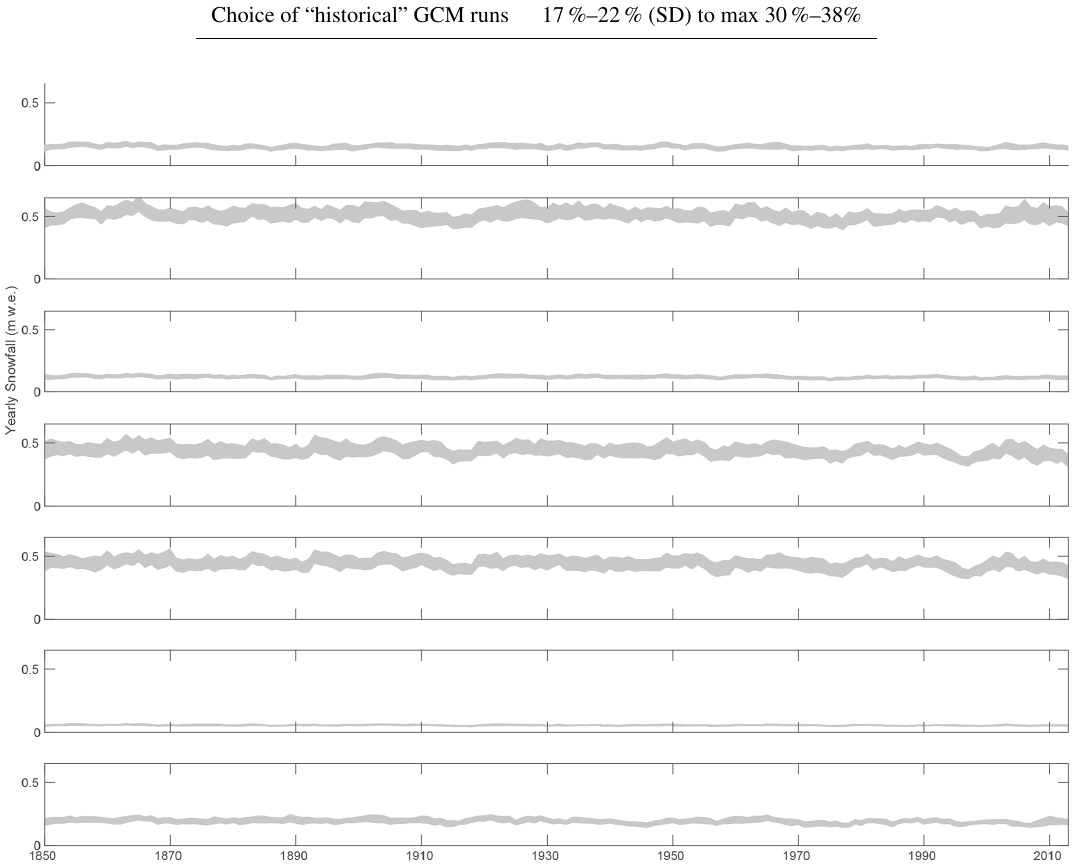
Figure 11. The downscaled CESM2 member 1 with 100 different analog draws is represented at the ice core sites. The uncertainty is between 5% and 10% of the mean